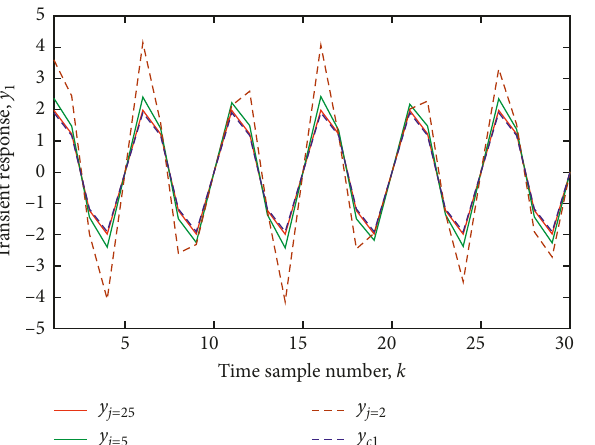
Figure 3: Outputs y 2 at the 2nd, 5th, and 25th iterations.